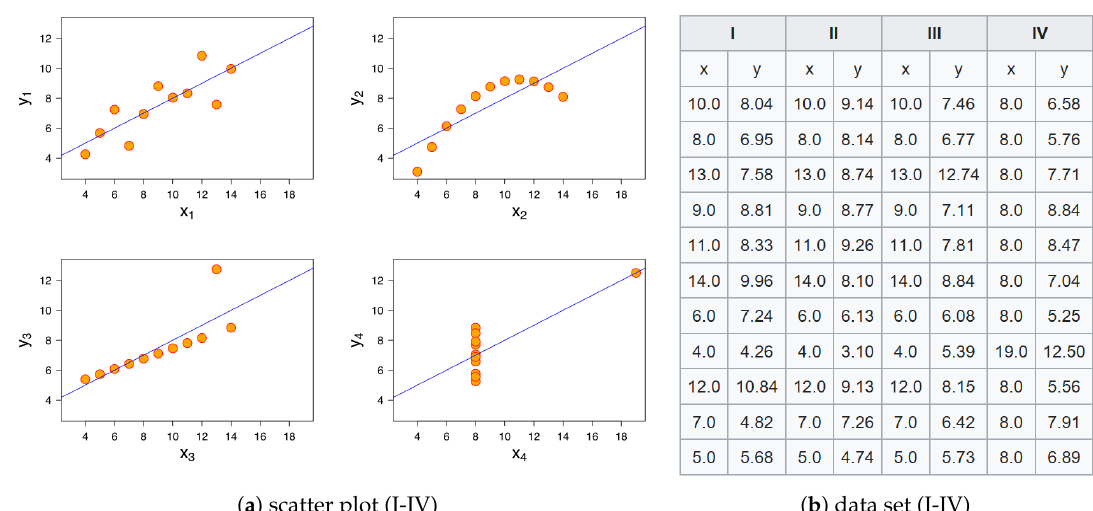
Figure A1. Anscombe’s quartet—dataset I (simple linear)/dataset II (nonlinear)/dataset III (linear with outlier)/dataset IV (a high-leverage point). Four datasets have the same mean, variance, Pearson correlation coefficient, R 2 , slope, and intercept of the best-fit line (Figure quoted from